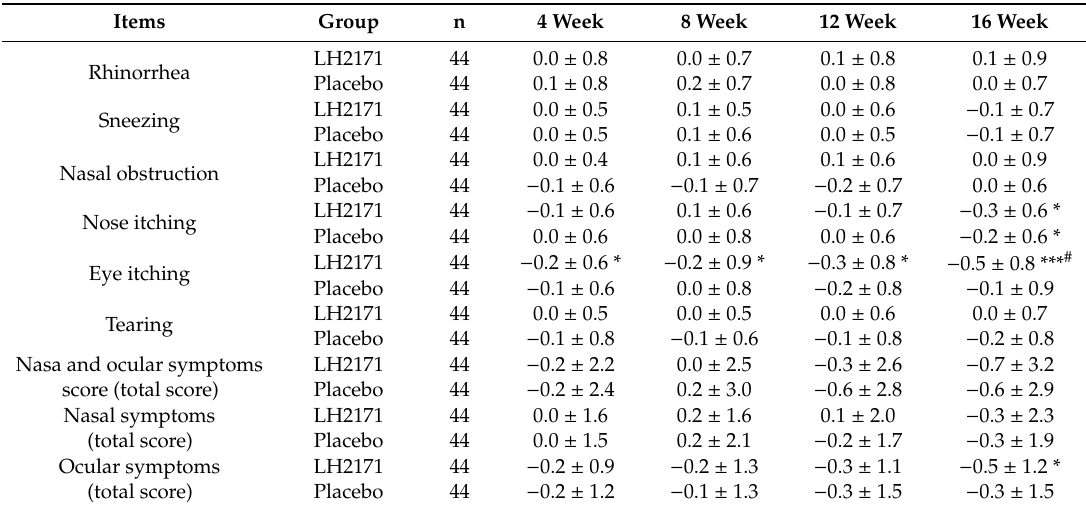
Table 8. Score changes in nasal and ocular symptoms as per the JRQLQ No.1 from 0 to 16 weeks in